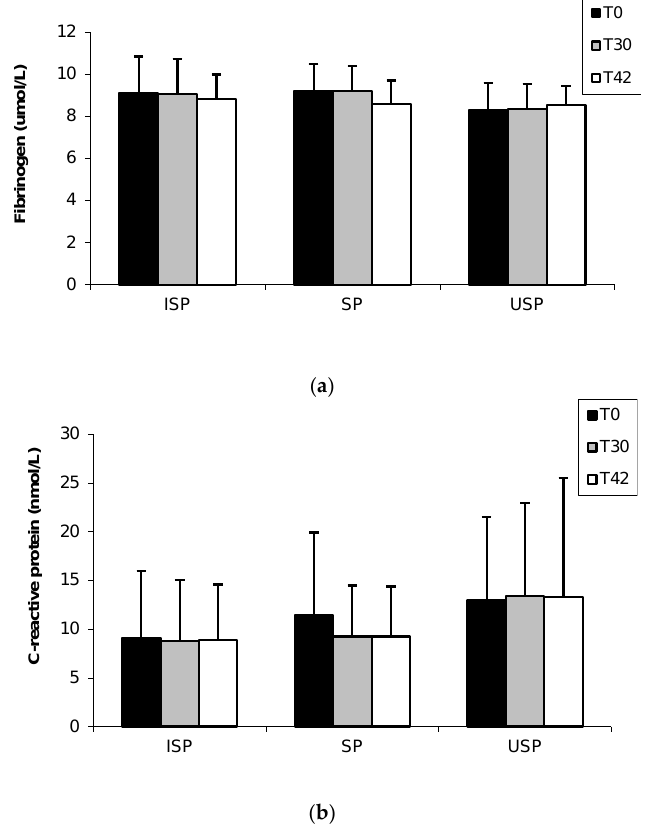
Figure 2. Fibrinogen ( a ) and C-reactive protein ( b ) concentrations during clinical trial. Values are mean ± SD. Means without significant differences between groups for the same sampling period of the study and without significant differences between sampling periods for the same study group ( p < 0.05). ISP Group: individuals who consumed the isoflavone-supplemented soy product; SP